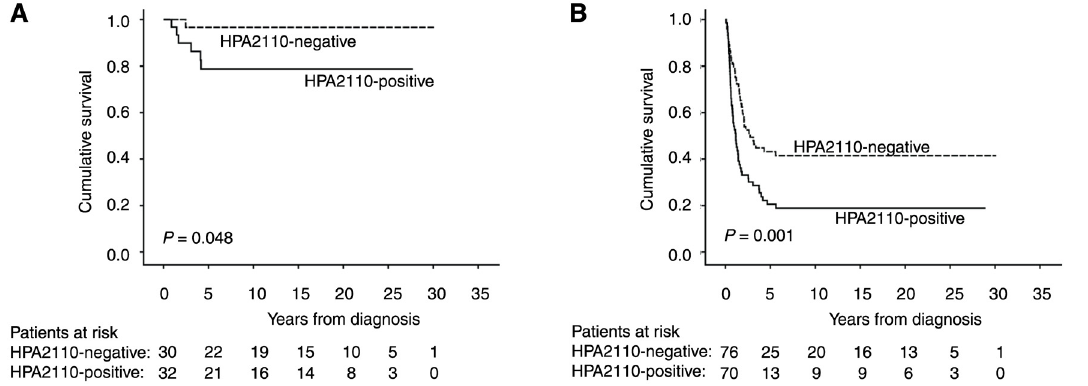
Fig 3. The expression of HPA2110 in the subgroups of (A) stage I patients, and (B) diffuse-type in gastric